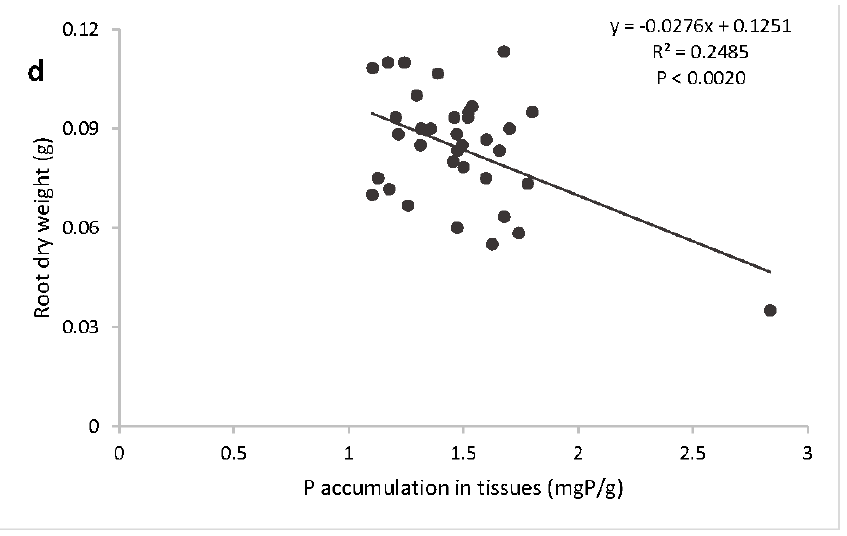
Figure 8. Correlation analyses for P uptake ( a , b ) and P accumulation ( c , d ) in tissues shoot dry and root dry weight of A. seyal (Delile) under saline conditions.